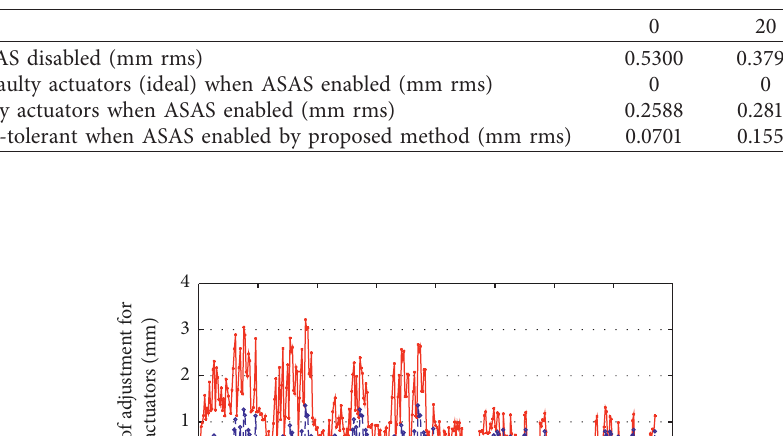
Table 3: Comparison of the main reflector rms after adopting fault-tolerant method.